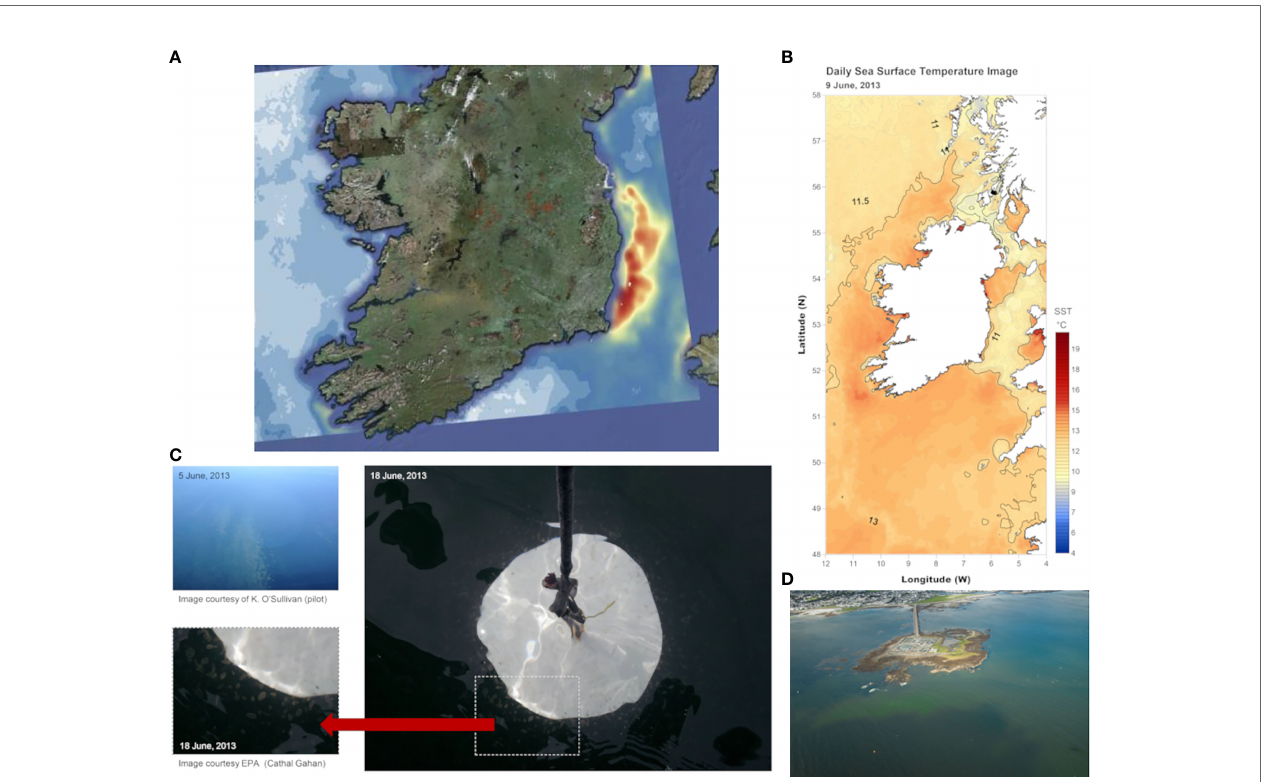
Figure 14 . On 28 th June, a call from the rescue services to the Oceanographic Centre of Vigo (IEO) raised the alarm that Samil Beach waters were discolored, probably due to a red tide.